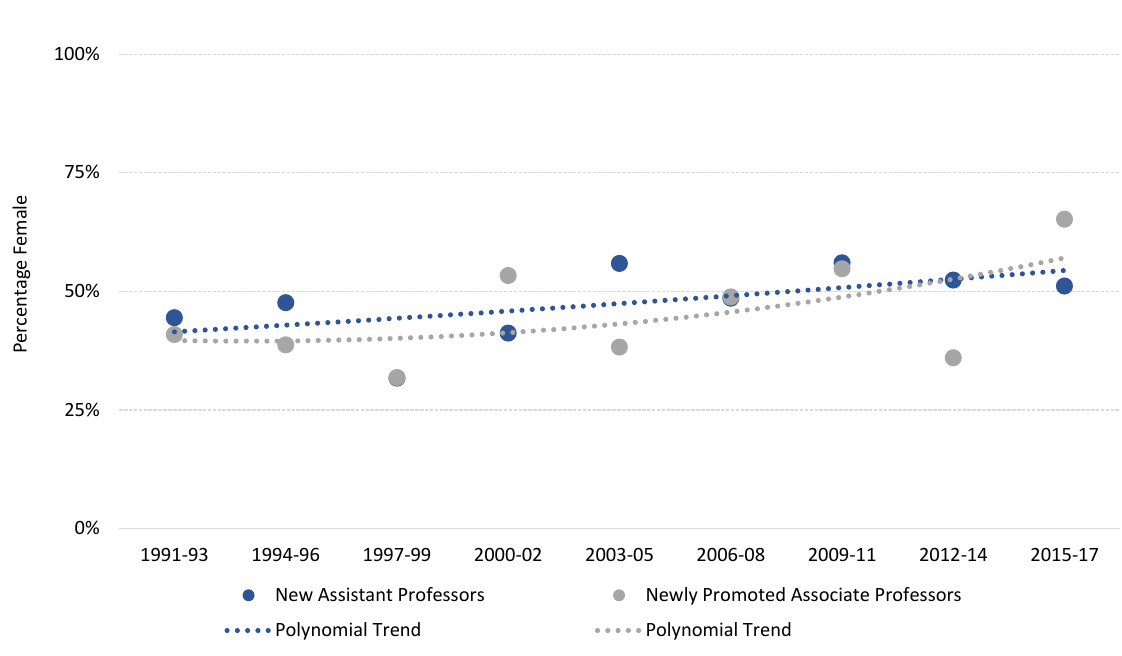
Figure 12: Percentage of new assistant and newly promoted associate professors who are female by year. who are female. In both cases, the share of faculty who are female has gradually risen over